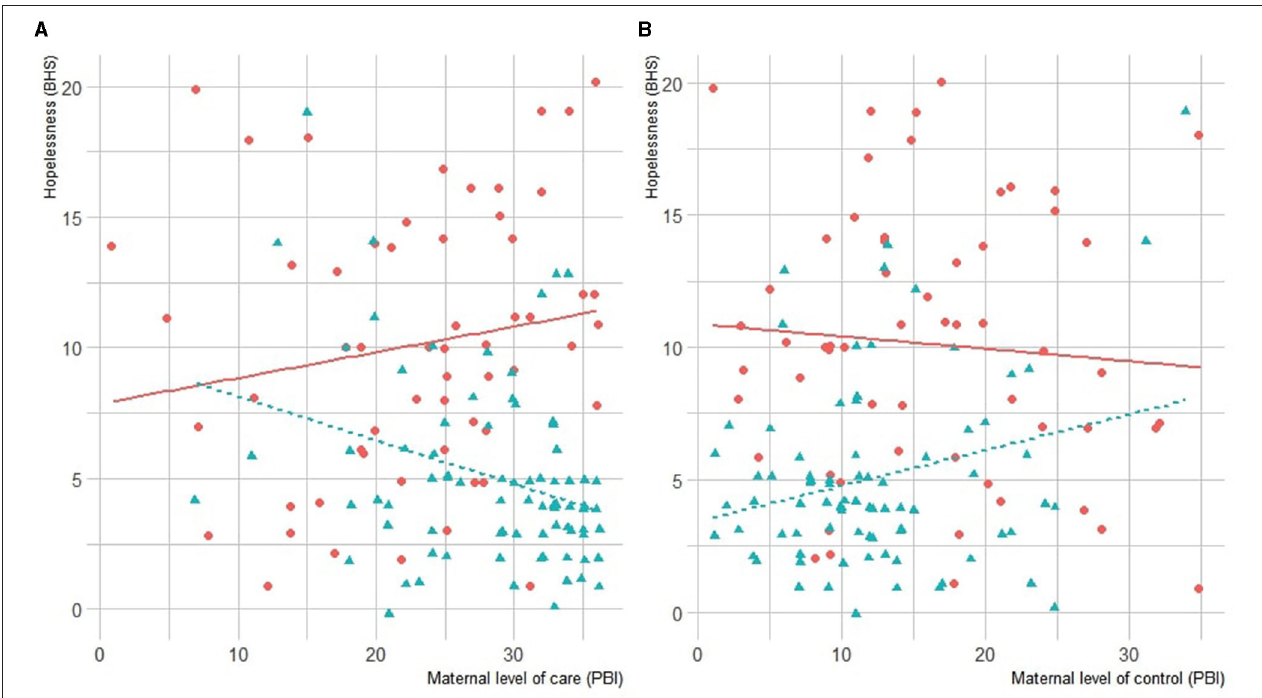
FIGURE 1 | (A) Correlation between maternal care and hopelessness. (B) Correlation between maternal control and hopelessness in BPD and HC groups. BPD scores are represented in blue, and HC’s in red. BHS, Beck Hopelessness Scale; BPD, Borderline Personality Disorder; HC, healthy controls.